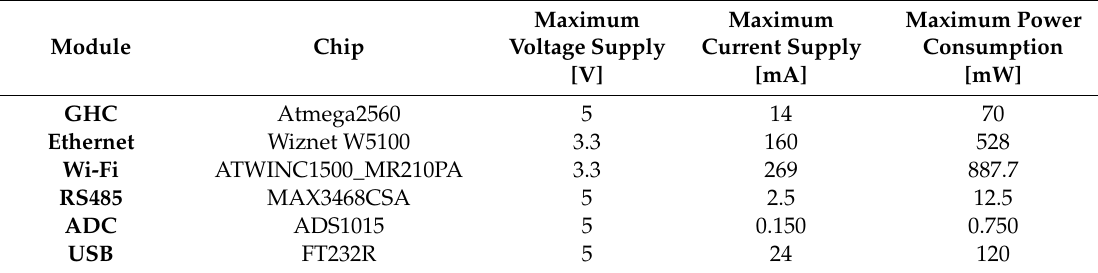
Figure 9. A 3D view of the Main Board: ( a ) front side; ( b ) back side. Table 7. Power consumption